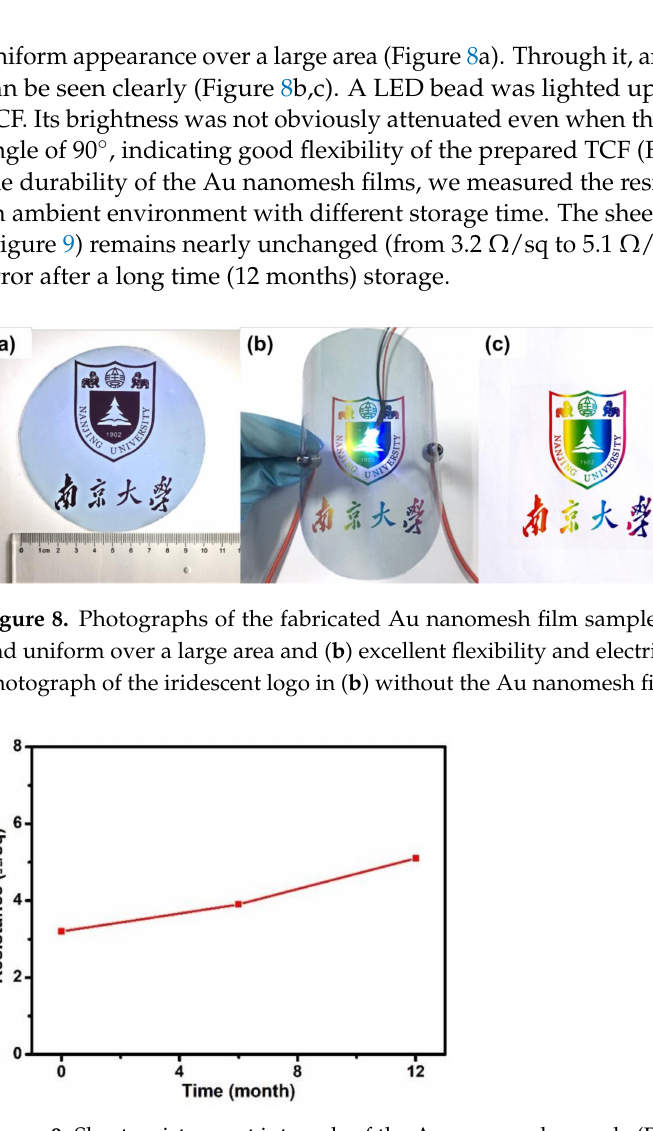
Figure 9. Sheet resistance at intervals of the Au nanomesh sample (R S = 3.2 Ω /sq, T =